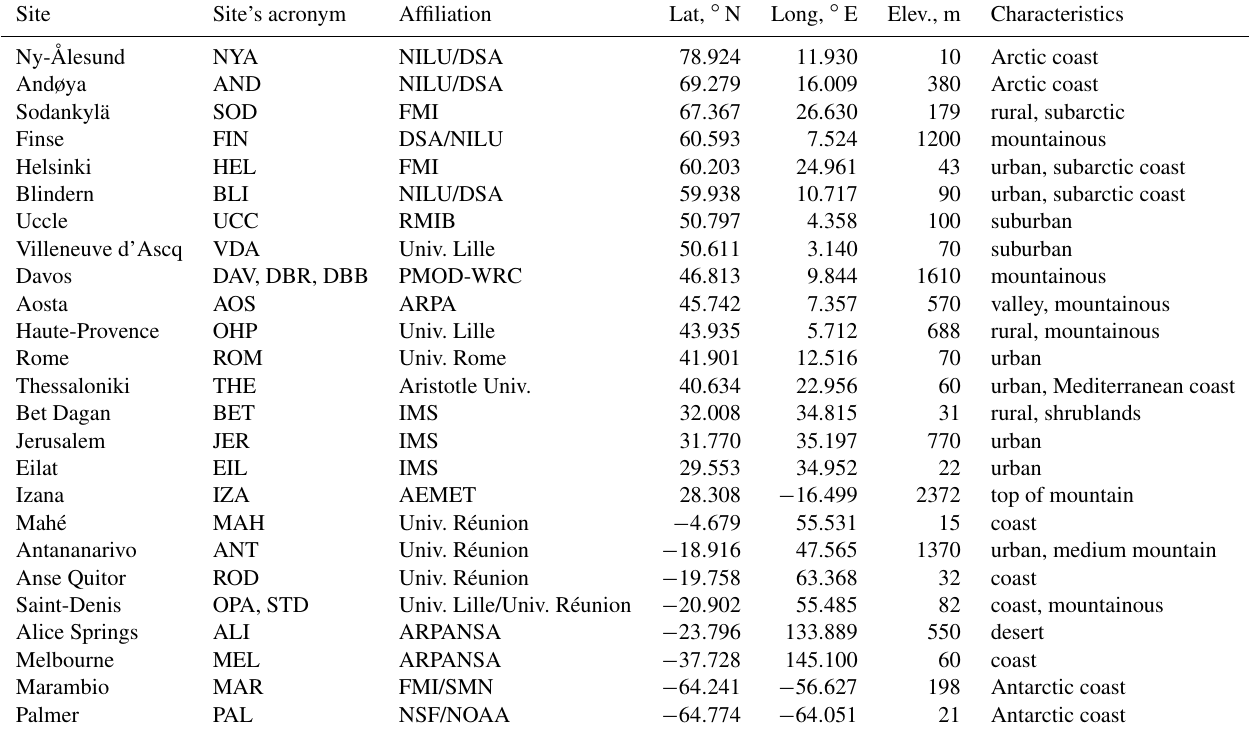
Table 2. Validation sites ordered according to latitude from north to south.